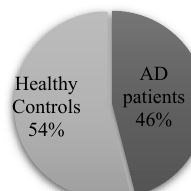
Figure 2. Distribution of the population described in the database by sex.